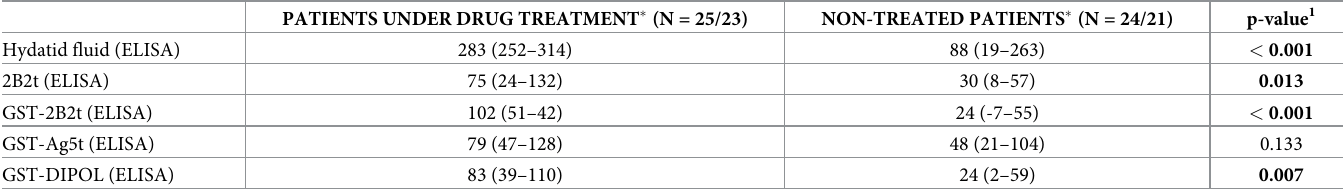
Table 5. Comparison of the SI of patients with CE4 cysts in non-treated patients and under drug treatment against hydatid fluid, B2t and 2B2t in